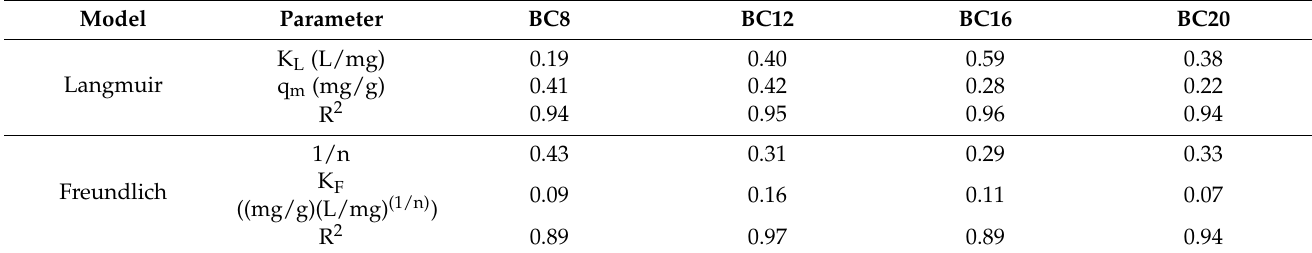
Figure 8. Langmuir and Freundlich isotherms for: ( a ) BC8; ( b ) BC12; ( c ) BC16; ( d ) BC20. Table 4. Langmuir and Freundlich isotherm parameters.